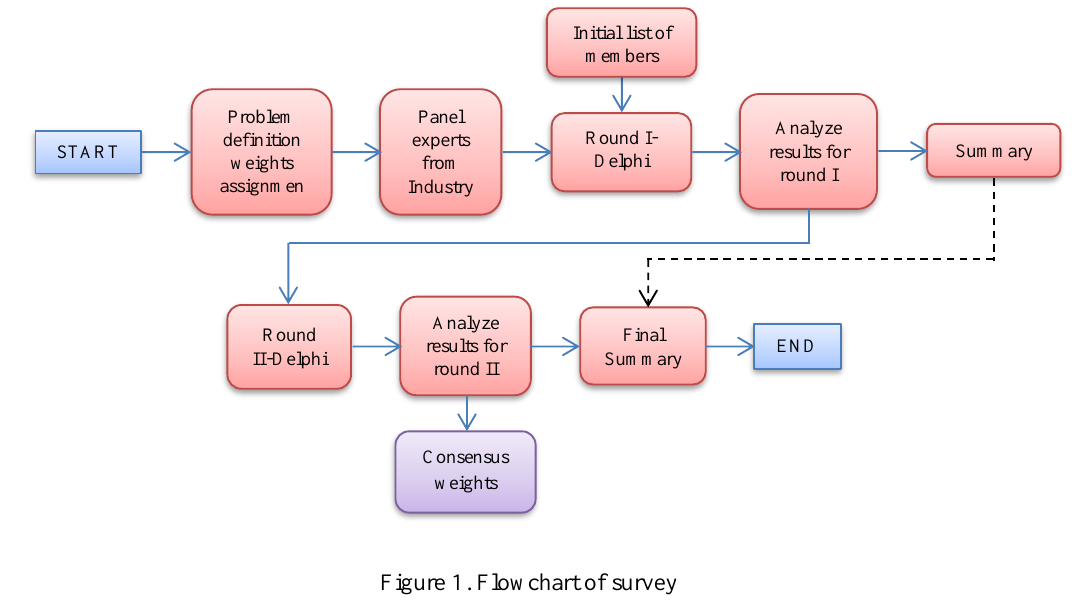
Figure 1. Flowchart of